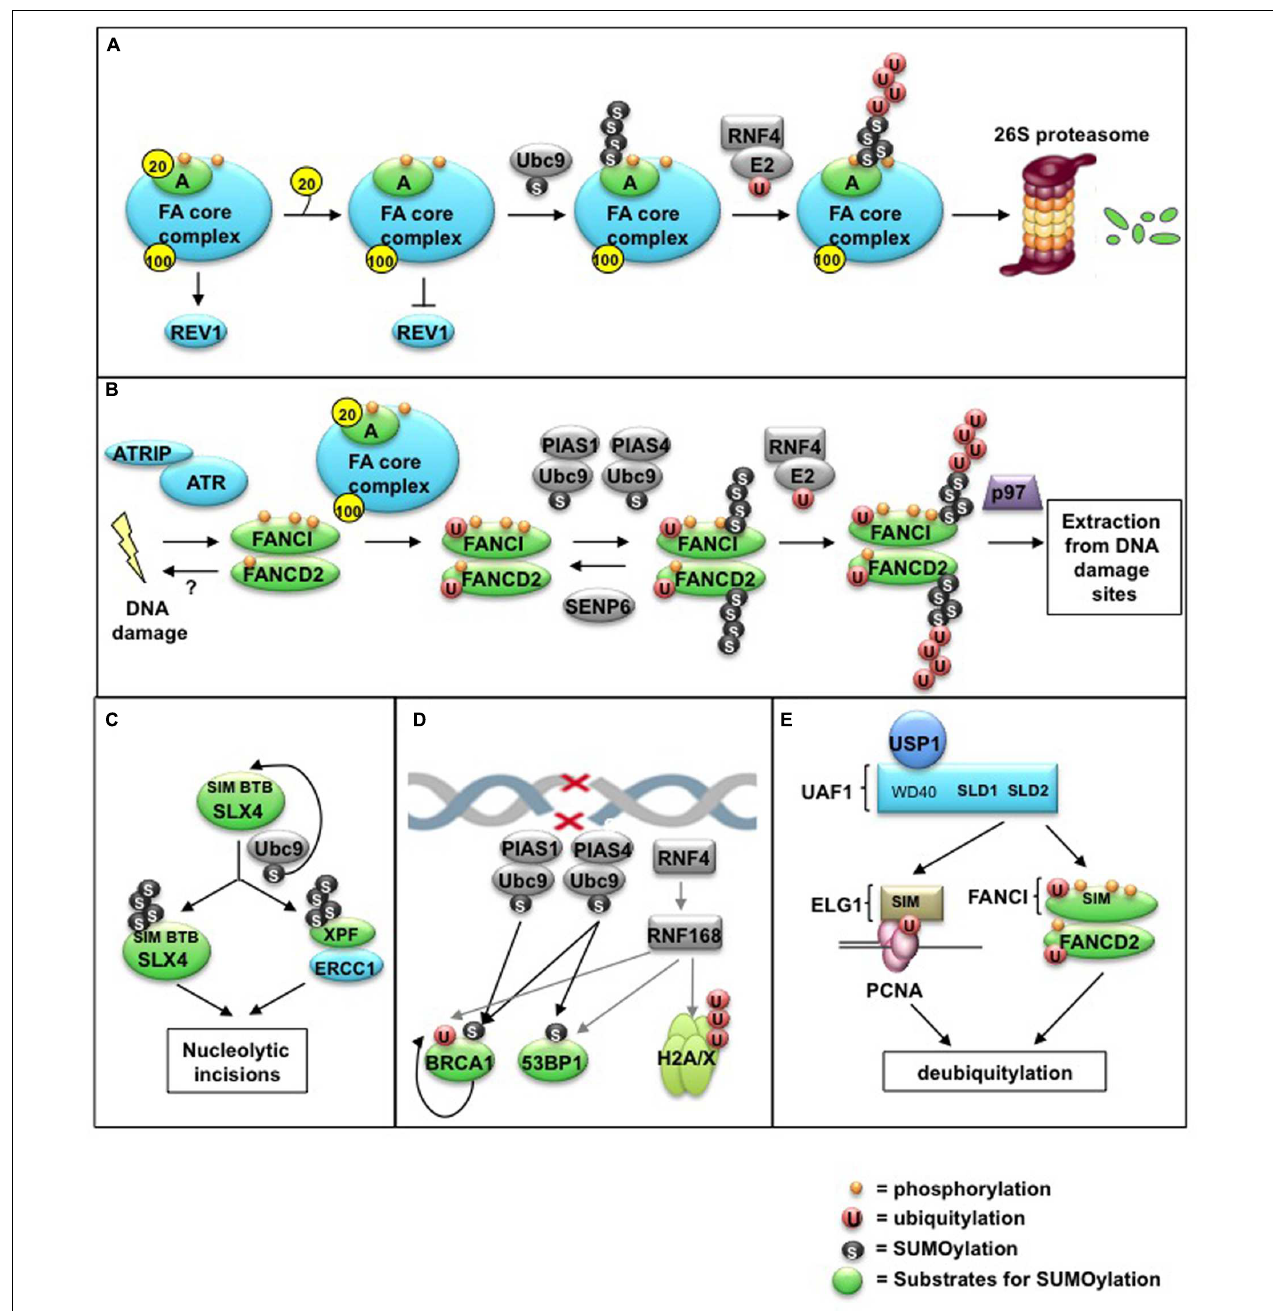
FIGURE 2 | Control of the FA pathway by SUMO and SUMO-like modifications. (A) Regulated release of the FAAP20 subunit from FANCA is required for SUMOylation of FANCA via the E2 conjugating enzyme Ubc9. Removal of FAAP20 inhibits the recruitment of the downstream TLS polymerase REV1 during ICL repair, resulting in decreased TLS-mediated mutagenesis. SUMOylation of FANCA subsequently triggers RNF4-mediated polyubiquitylation and proteasome-mediated degradation. (B) The ID complex is targeted for SUMOylation in a manner dependent on the activities of the ATR kinase, the FA core complex, and the SUMO E3 ligases PIAS1/PIAS4. Alternatively, SUMOylation can be removed by the SUMO protease SENP6. SUMOylation of the ID complex allows for recognition by RNF4, leading to ID complex polyubiquitylation and removal from damage sites via the DVC1-p97 segregase complex. (C) The SLX4 complex acts as a SUMO E3 ligase by triggering its own SUMOylation in addition to that of the DNA repair/recombination endonuclease XPF. This SLX4-dependent SUMOylation is dependent on the E2 Ubc9, as well as its own SIMs and BTB domains, and is important to prevent mitotic catastrophe following CFS expression. (D) The SUMO E3 ligases PIAS1 and PIAS4 promote DSB repair by localizing to damage sites and SUMOylating multiple target proteins, including BRCA1 and 53BP1. This SUMOylation is required for proper ubiquitin-adduct formation mediated by RNF8, RNF168, and BRCA1 to initiate a DNA damage response (DDR). (E) The SUMO-like domain SLD2 of UAF1 directs USP1-UAF1 targeting to its substrates via SIMs located within FANCI and the PCNA-interacting protein hELG1. These SLD-SIM interactions regulate deubiquitylation of FANCD2 and PCNA-Ub substrates, respectively, to coordinate HR and TLS activities during FA DNA repair.